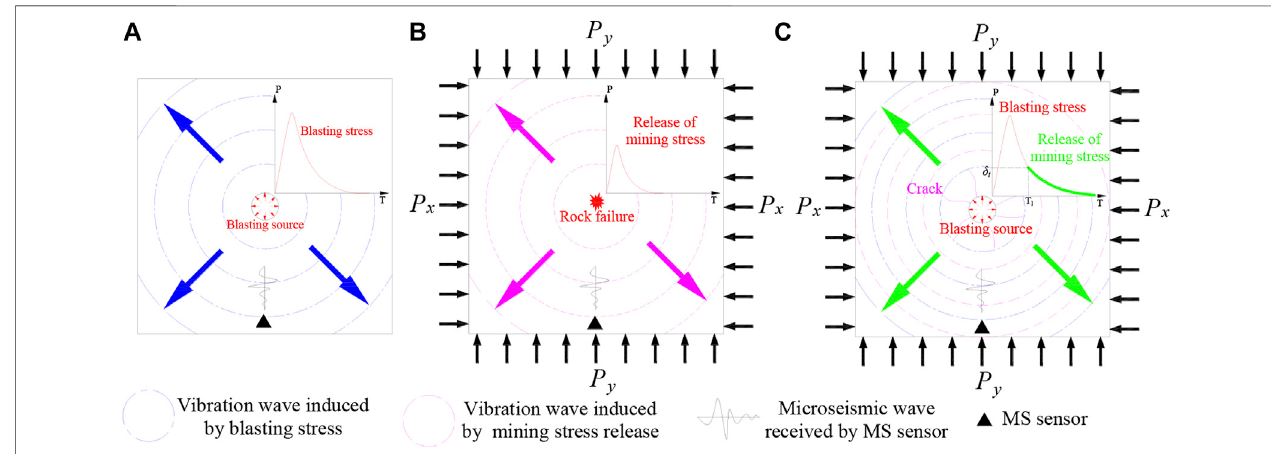
FIGURE 6 | External disturbance characteristics of different types of induced microseismic waveforms. (A) Ground blasting-induced microseismic; (B) mining- induced microseismic; and (C) destress blasting-induced microseismic.